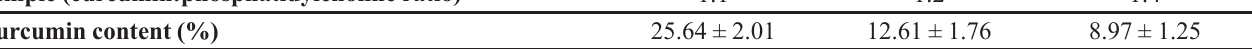
TABLE II - Curcumin content in the phytosome Sample (curcumin:phosphatidylcholine ratio)